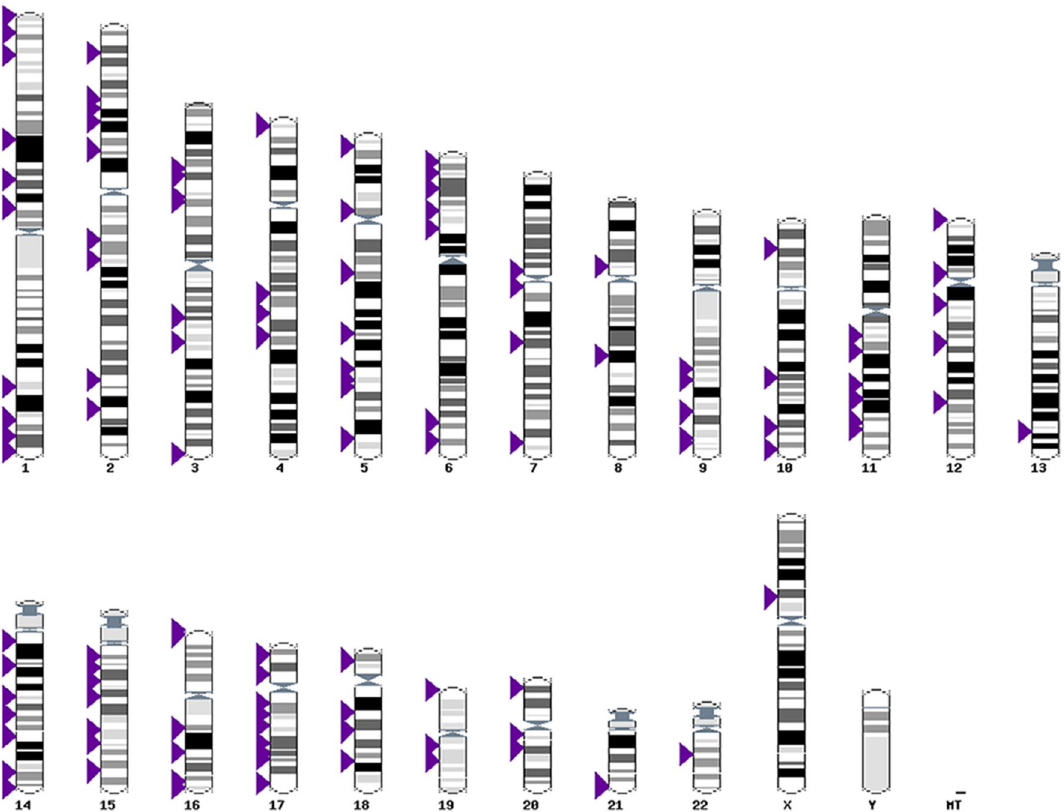
Figure 2. Karyotype display for all of the genetic loci analysed for non-syndromic orofacial cleft in the populations of European ancestry (purple arrowheads) that were extracted from the 84 studies selected. Data are presented using Ensembl genomic browser, release 101 72